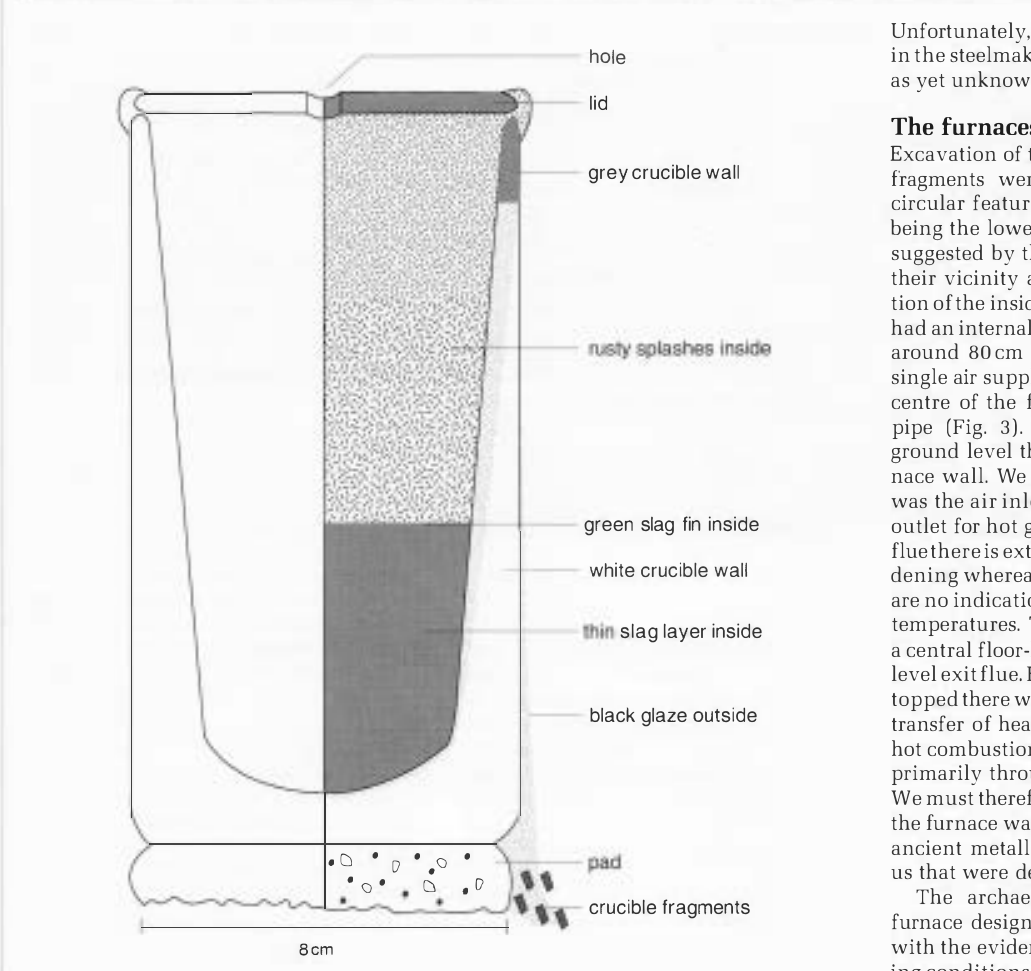
A schematic reconstructed cross section through one of the steelmaking cru­ cibles found at Gyaur Kala, Merv. the prills in the green glassy fin and the rust-coloured nodules could thus have originated from splashes of molten